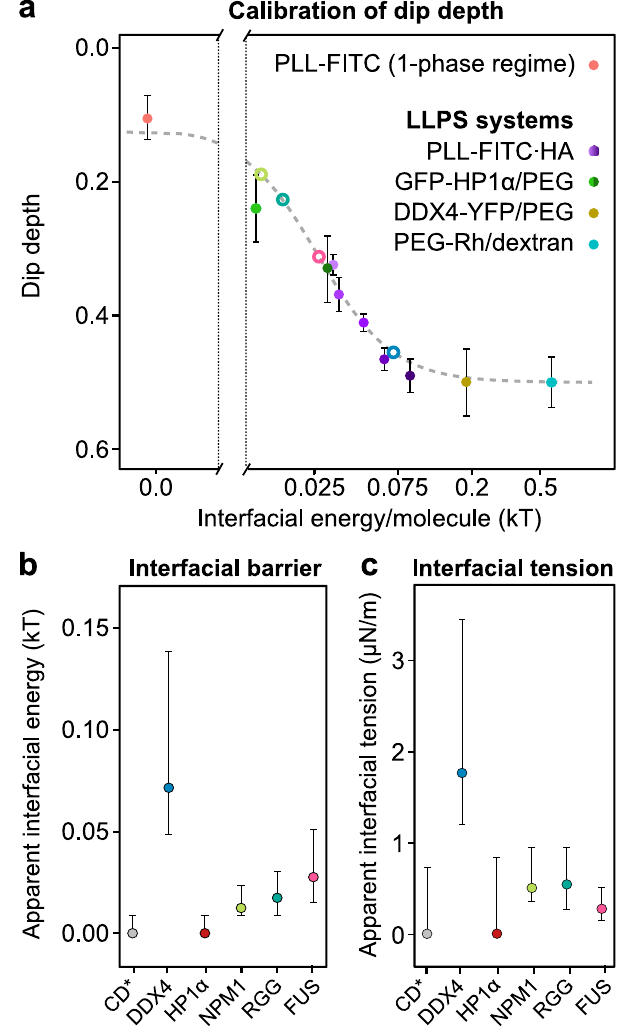
Fig. 4 | MOCHA-FRAP quanti fi es interfacial barriers based on the dip depth. a Relationship between dip depth and interfacial energy per molecule for PLL-HA undergoingLLPS(violet;magnesiumchlorideconcentrationsincreasefromdarkto light color), GFP-HP1 α /PEG (dark green: without ssDNA; light green: with ssDNA), DDX4-YFP/PEG (gold) and PEG-Rhodamine/dextran (cyan) measured in vitro. As a reference, free PLL in the 1-phase regime is shown (red). The error bars represent the standarderror of the mean. Open circles represent dip depths obtainedin live- cell experiments, following the same color code as in the panels below. Apparent interfacial energy per molecule, which serves as a proxy for the interfacial barrier ( b ), and apparent interfacial tension ( c ) calculated from the dip depth of CD*-YFP, DDX4-YFP, GFP-HP1 α , NPM1-GFP, RGG-GFP-RGG and FUS-mCherry in living